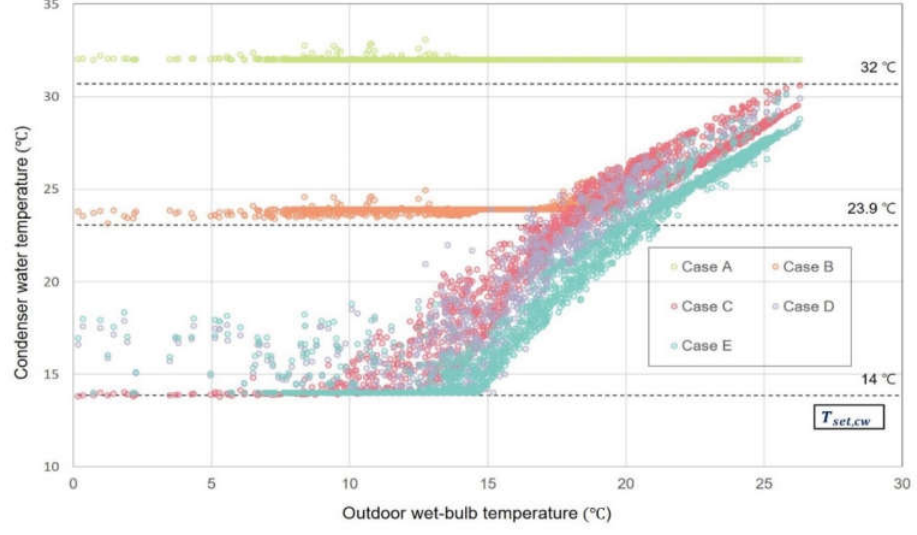
Figure 16. Relation between condenser water and outdoor wet-bulb temperature for Case A–E.